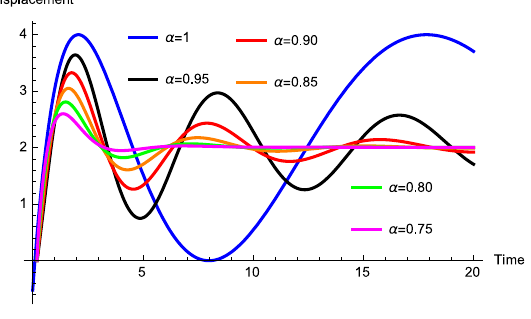
Figure 12. Numerical simulation for Equation (53) considering different values of α , arbitrarily